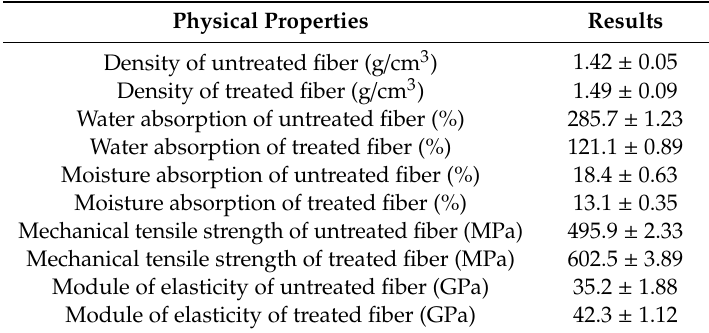
Table 2. Result of the physical characterization of the fiber.